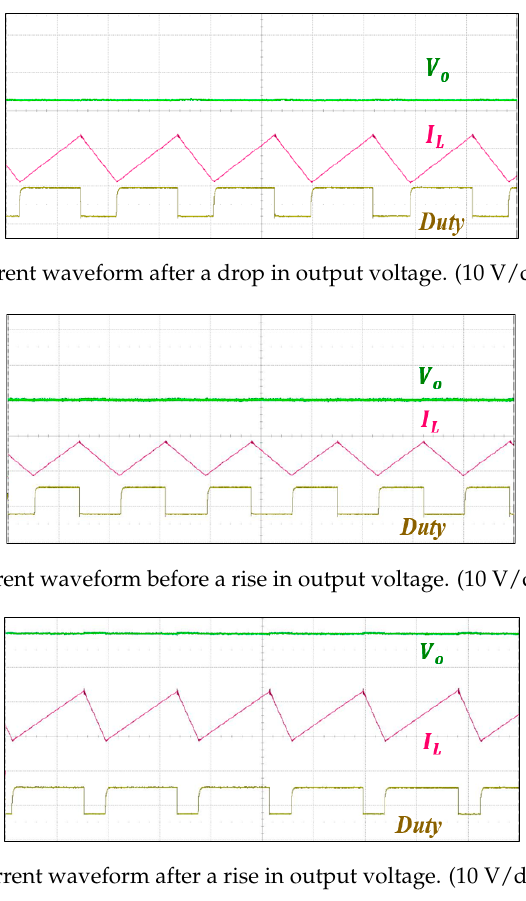
Figure 28. Inductor current waveform after a rise in output voltage. (10 V/div, 1A/div, 25 us/div).